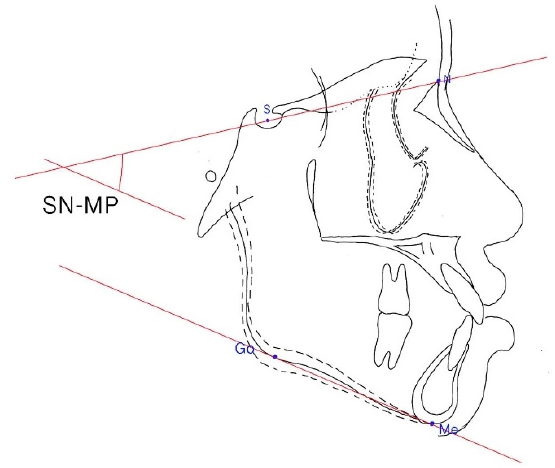
Figure 5. Sella-nasion plane to the mandibular plane (SN–MP) angle. The SN-MP angle was formed by the intersection of the SN plane and the mandibular plane.